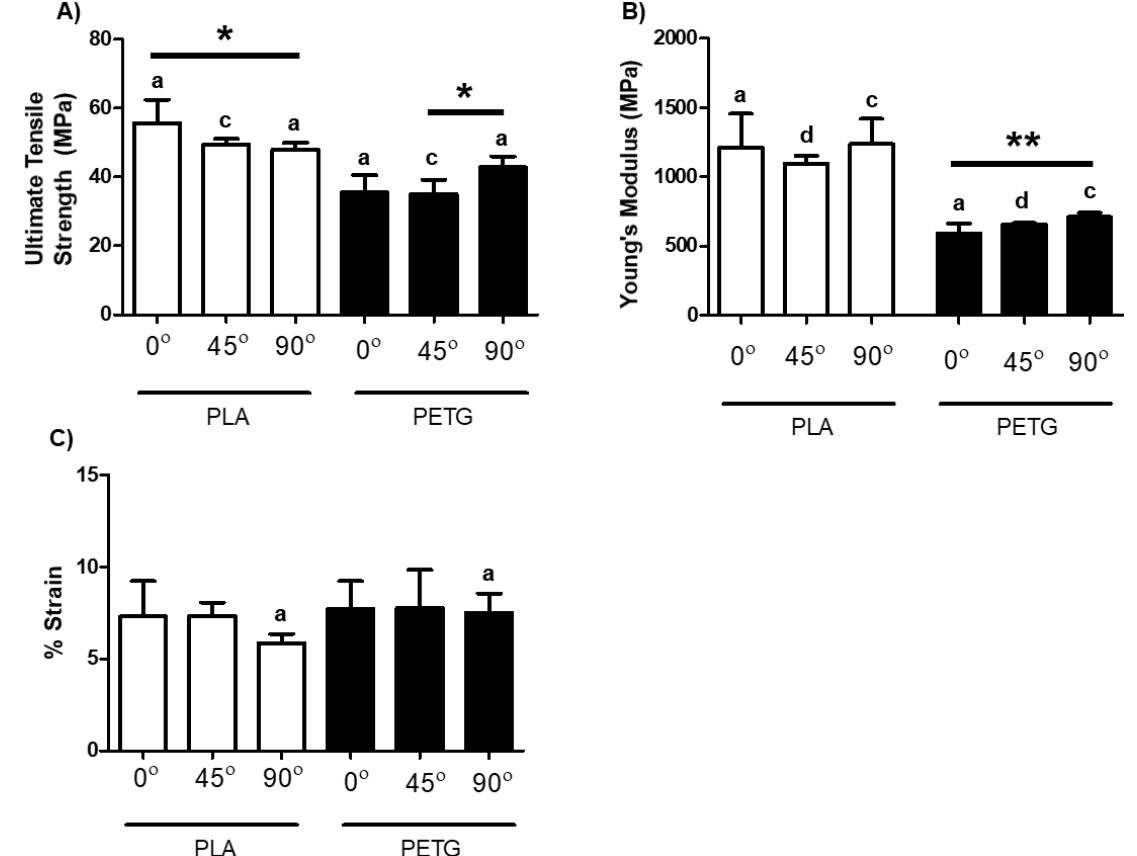
Figure 4. Mechanical properties of PLA and PETG at three differing raster angles: 0°, 45°, and 90°. ( A ) UTS; ( B ) Young’s modulus; ( C ) percent strain at failure. The letter denotation indicates a significant difference exists between PLA and PETG within the same raster angle. a Significant difference of p < 0.05. b Significant difference of p < 0.01. c Significant difference of p < 0.001. d Significant difference of p < 0.0001. * p < 0.05. ** p < 0.01. Data shown represent the mean ± SD. a–d indicates significant